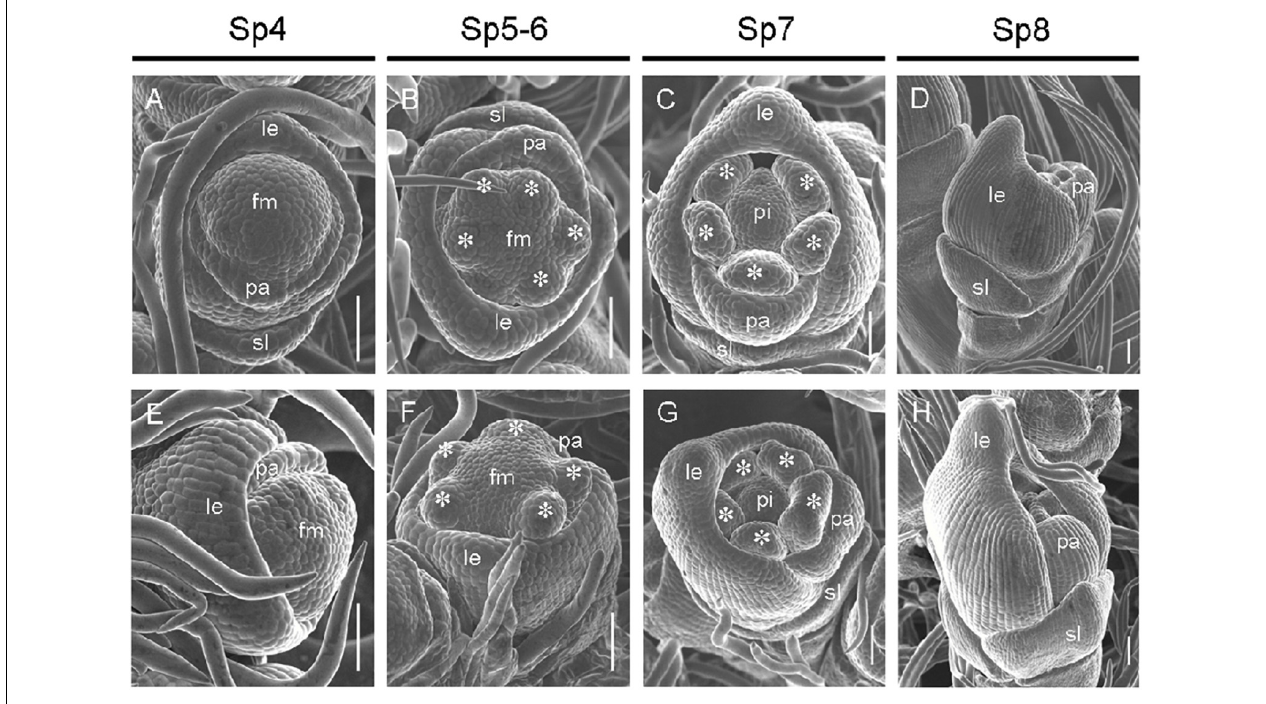
FIGURE 3 | Florets at early developmental stages in the wild-type and the mr1 mutant. (A–D) Wild-type floret. (A) Sp4. (B) Sp5-6. (C) Sp7. (D) Sp8. (E–H) mr1 floret. (E) Sp4. (F) Sp5-6. (G) Sp7. (H) Sp8. fm, floral meristem; sl, sterile lemma; le, lemma; pa, palea; pi, pistil. Asterisk indicates the stamen. Bars, 50 µ m.